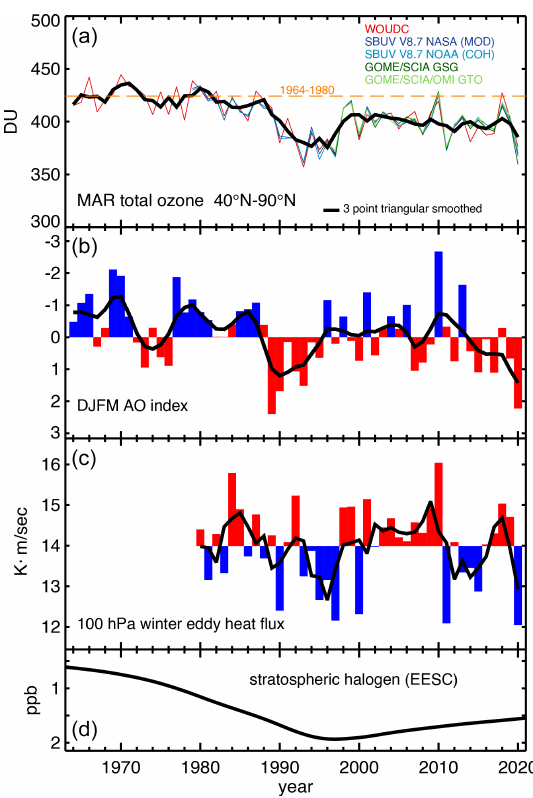
Figure 6. (a) March NH total ozone (40–90 ◦ N) from the five bias- corrected merged datasets (coloured) and the smoothed median time series (thick black line). (b) DJFM Arctic Oscillation (AO) index. Black lines shows the three-point triangular smoothed time series. Note the inverted y scale. (c) 100hPa winter eddy heat flux Septem- ber to March average (BDCn proxy), with the black line showing the three-point triangular smoothed time series. (d) Inverted strato- spheric halogen time series in parts per billion (ppb), representative of middle latitudes (Newman et al., 2007).